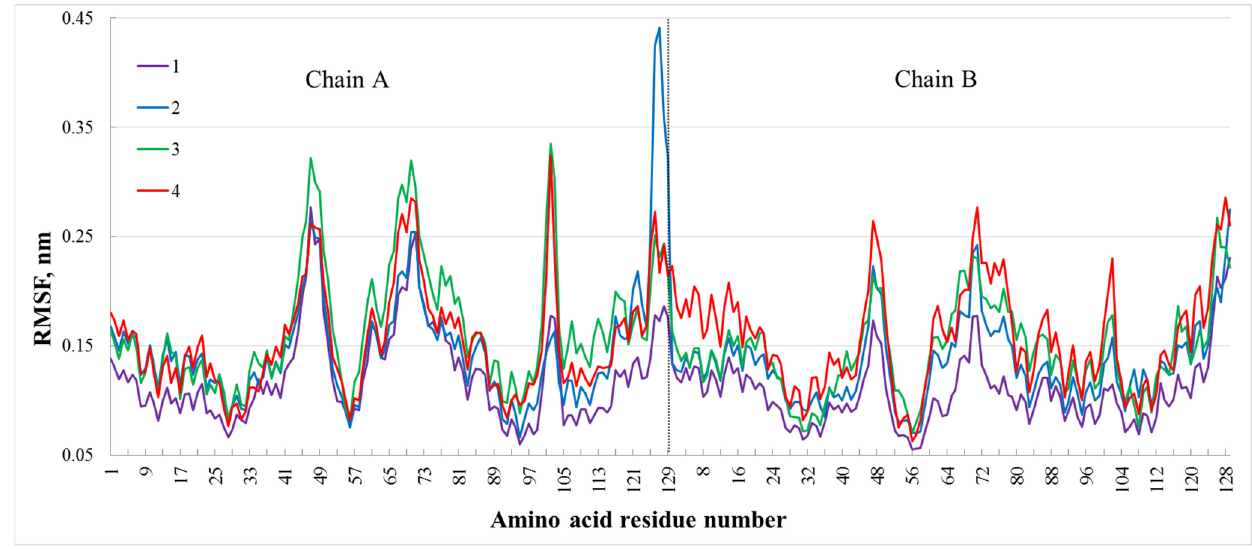
Figure 1. RMSF graphs of C α atoms of different models of dimers simulated in a solution with a precipitant: with Na and Cl ions, bound to the protein (1), only with Na ions in the dimer structure (2), and without precipitant ions embedded in the lysozyme molecule (3), as well as without Na and Cl ions both in solution and in the protein structure (4).